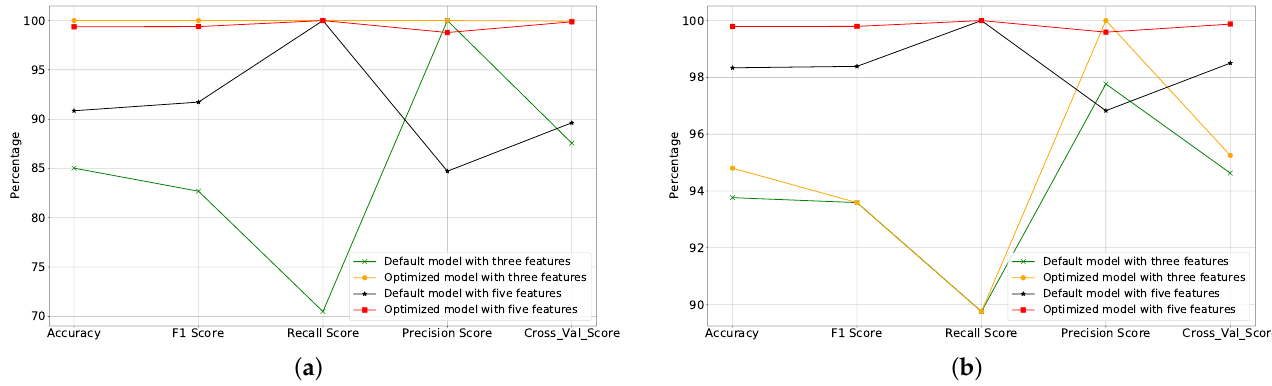
Figure 12. Performance evaluation of SVM and NB algorithms: ( a ) SVM algorithm; ( b ) NB algorithm.